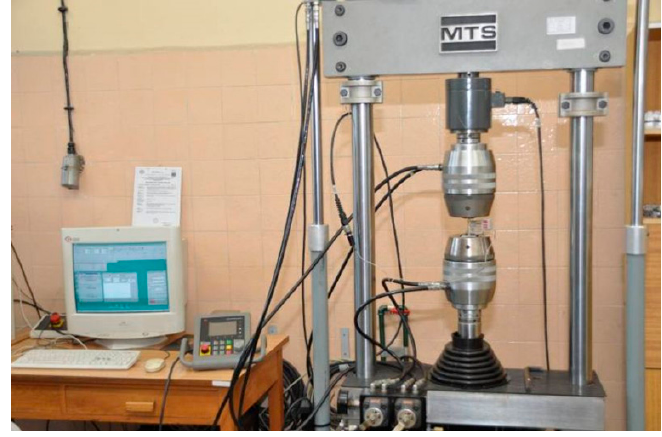
Figure 2. Measure, test, simulate ( MTS) tensile testing machine. Hydraulic strength testing machine allowed for accurate and repeatable tests on five types of shock absorbers. Digital controllers provided fast closed-loop control and a 100 Hz data acquisition rate. Load cells were checked during testing to ensure high rigidity and stability with low nonlinearity. The research assumed that the maximum deflection would not be more than 20% of the height of the shock absorber—Figure 3: